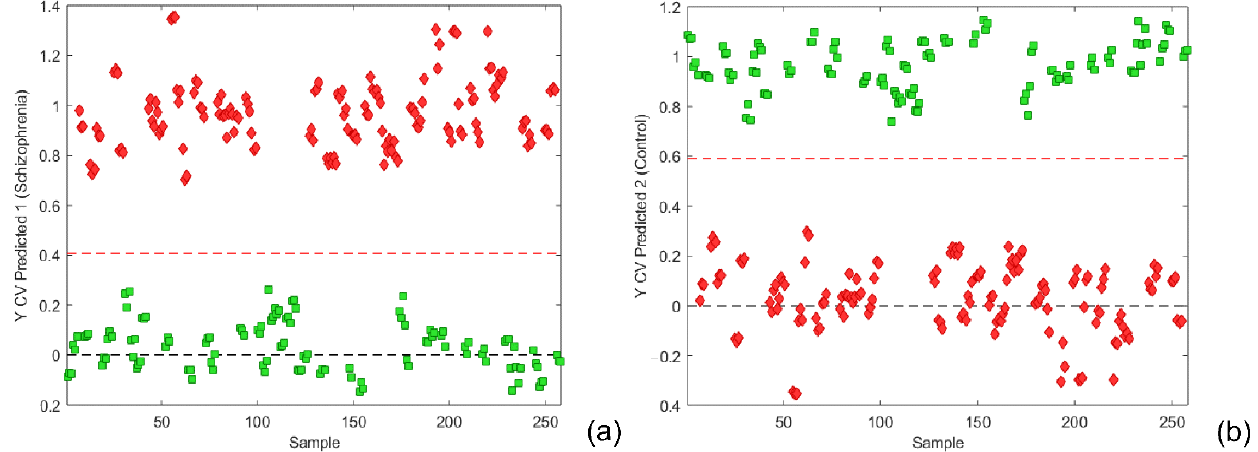
Figure 2. ( a ) Y CV Predicted for the class ‘Schizophrenia’ and threshold value of 0.4086; ( b ) Y CV Predicted for the class ‘Control’ and threshold value of 0.5914 using autoscaling. The schizophrenia cohort is shown in red, and the control group in green.